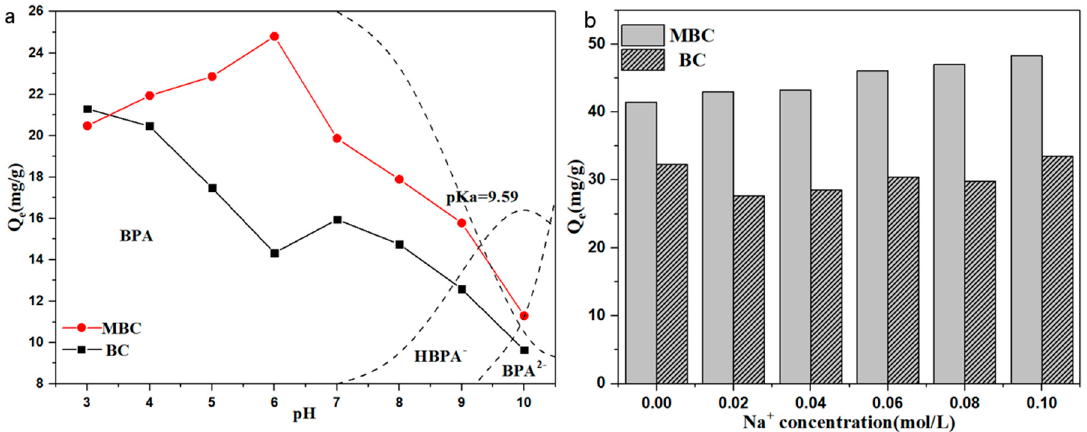
Figure 6. Effects of pH ( a ) and Na + concentration ( b ) on the adsorption of BPA by BC and